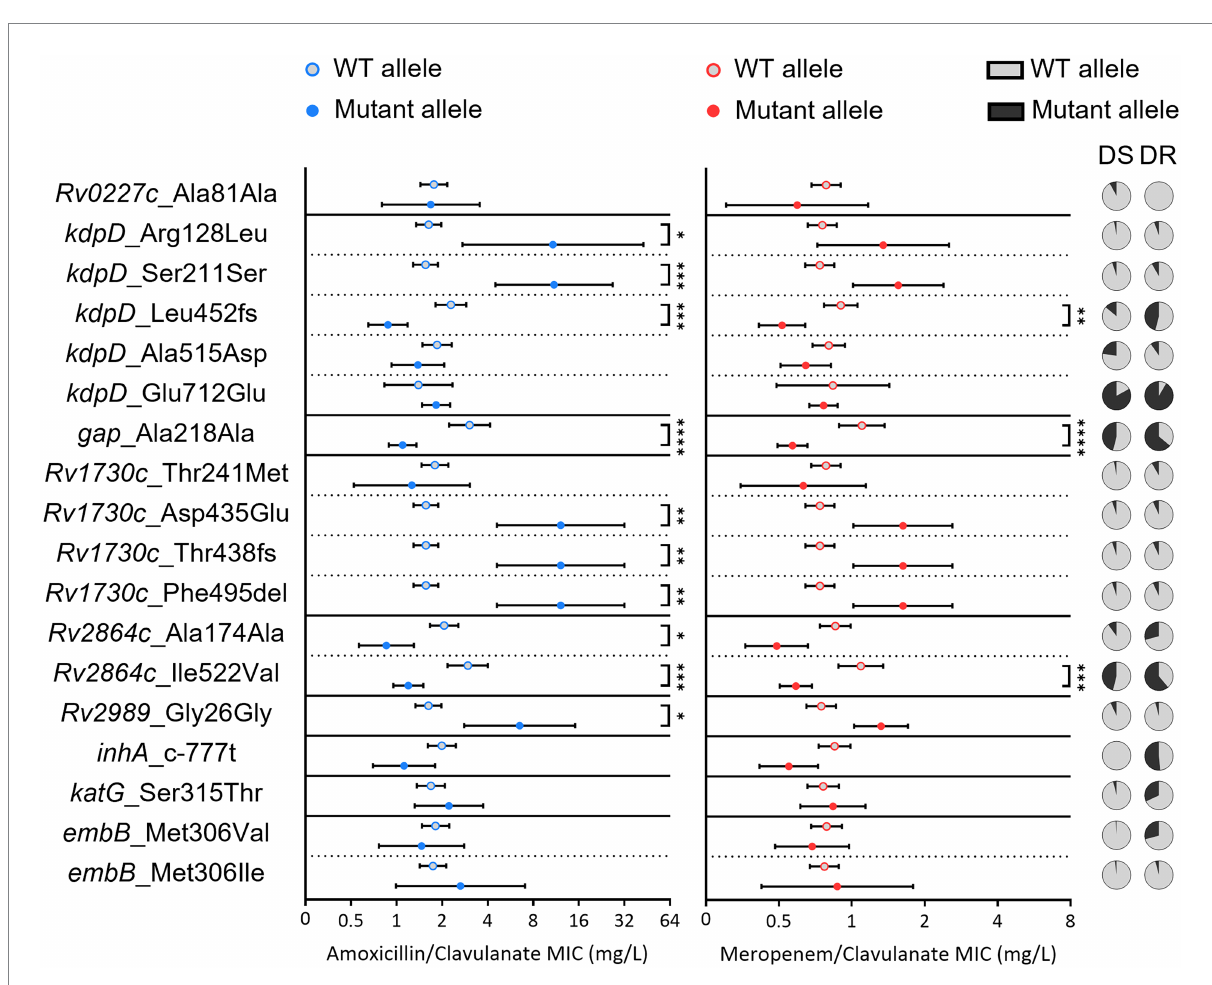
FIGURE 7 Beta-lactam susceptibility of Mtb clinical strains with mutations in relevant target or orthologue genes. The geometric mean minimum inhibitory concentration of amoxicillin/clavulanate (blue) or meropenem/clavulanate (red) for clinical strains carrying the wild type (WT) (gray dots with color outline) or mutant allele (full color dots) is depicted for each considered amino acid substitution. Error bars show a 95% confidence interval. A Kruskal–Wallis test was performed to evaluate statistically significant differences between the two groups for each mutation: *when p ≤ 0.05; **when p ≤ 0.01; ***when p ≤ 0.001; ****when p ≤ 0.0001. Pie charts represent the distribution of each mutation in anti-TB drug-susceptible (DS) and drug-resistant (DR)